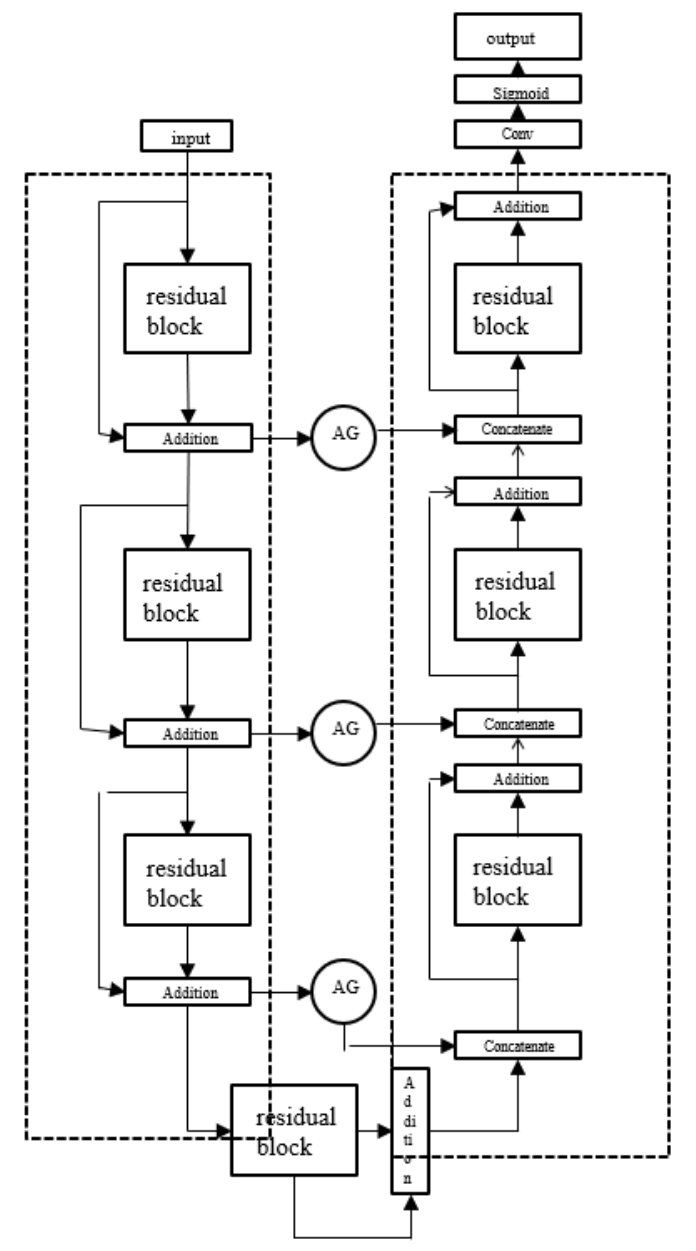
Figure 3. RAU-Net network architecture.